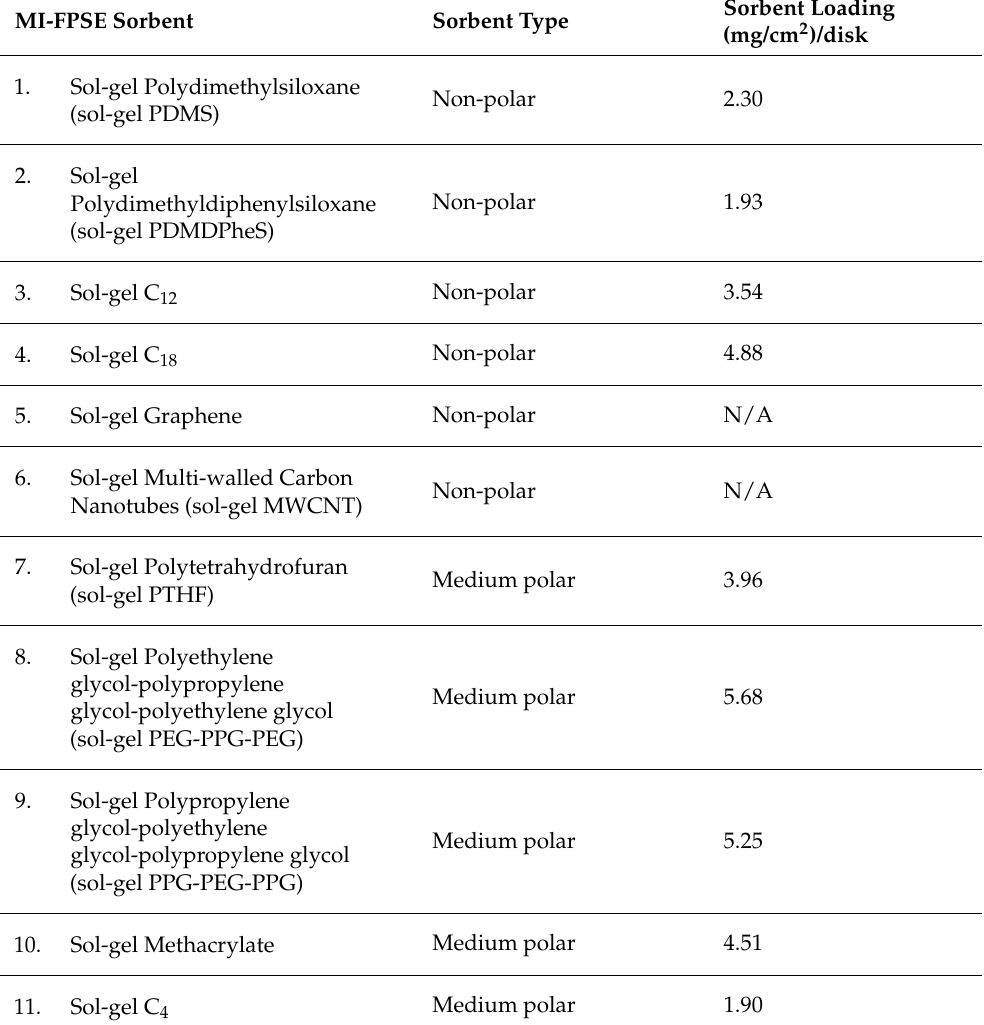
Table 1. MI-FPSE sorbent chemistries with other pertinent